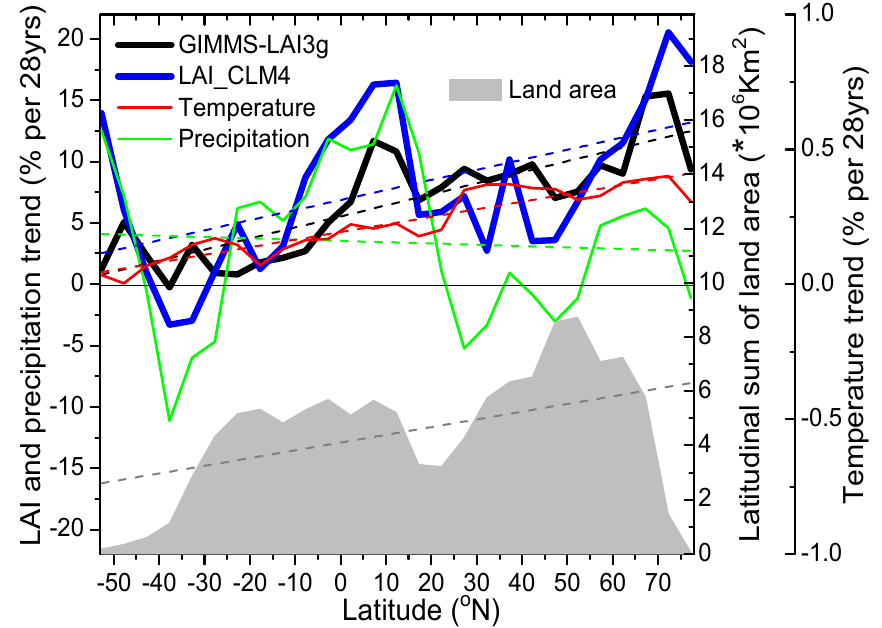
Table 1. Latitudinal trend (TREND_LAT) and spatially averaged annual